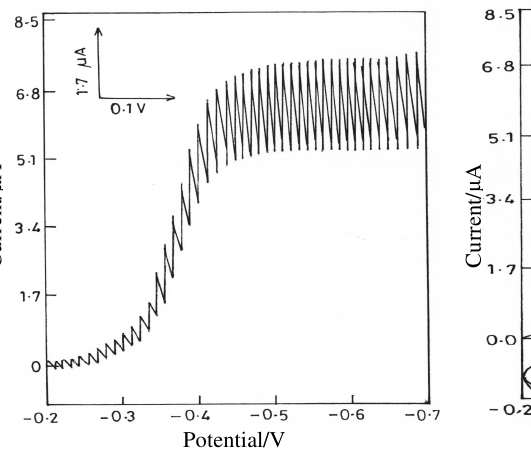
Figure 2. Typical cyclic voltammogram of fluchloralin in pH 4.0, Con: 0.5 mM Scan rate: 40 mVs